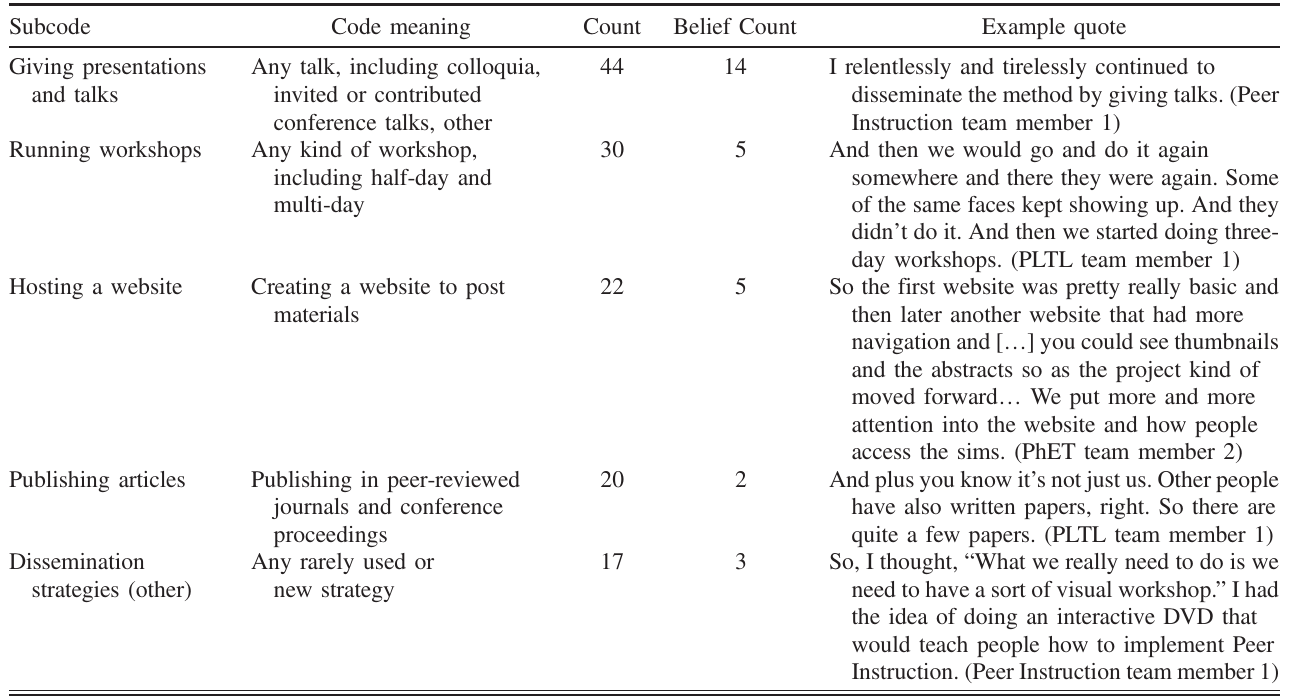
TABLE VII. Frequently used subcodes and example quotes for the dissemination strategies